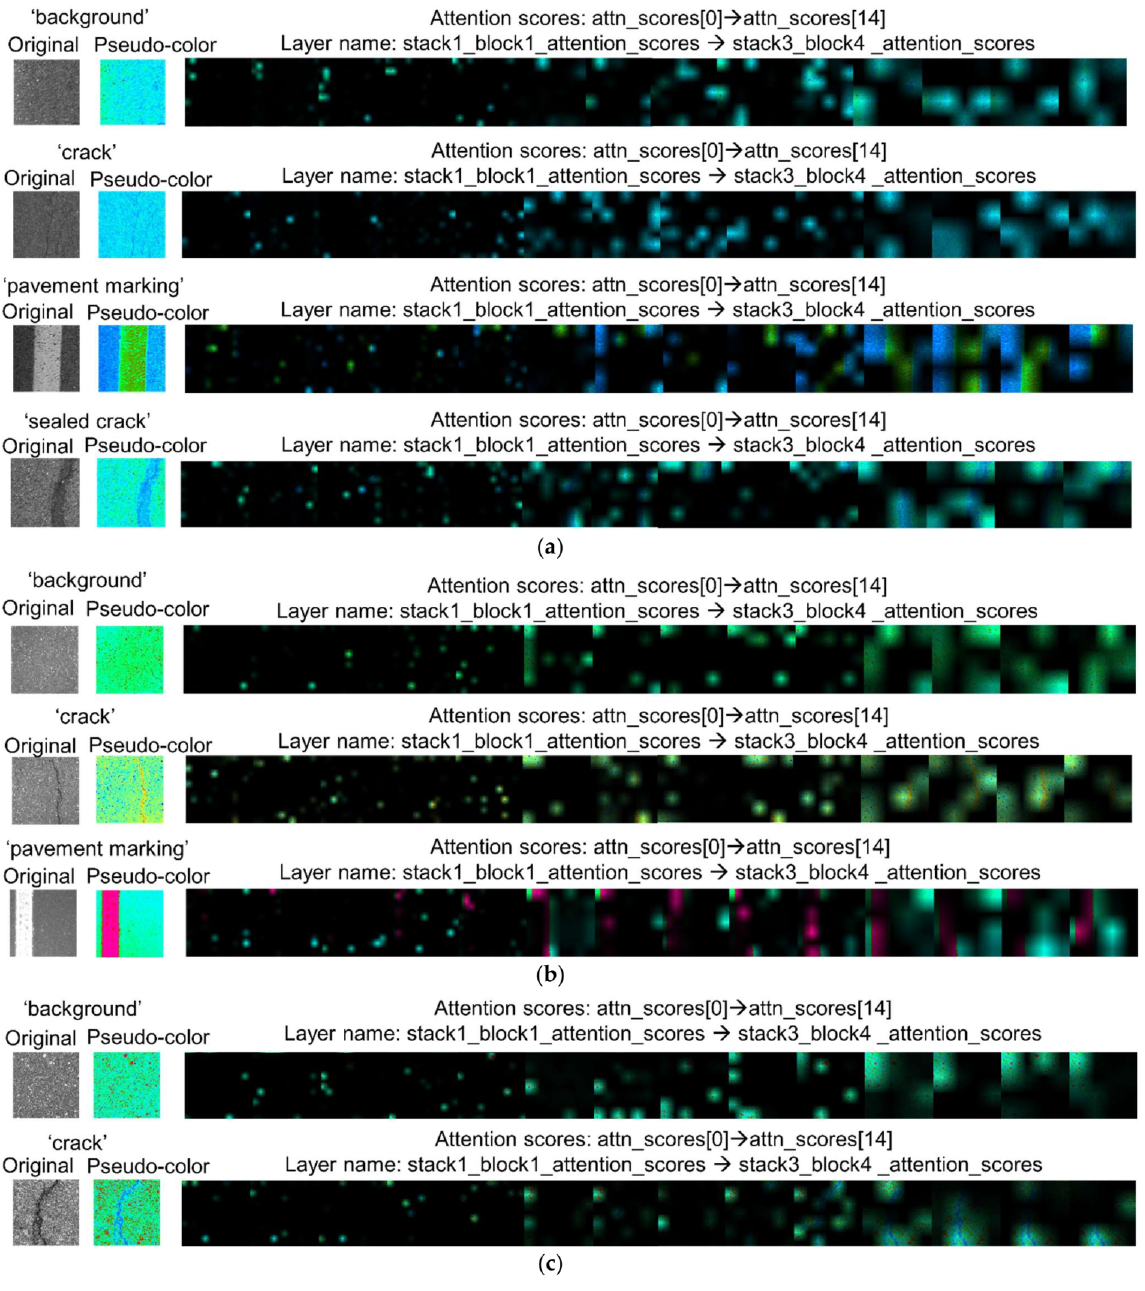
Figure 15. The attention score maps of different classifications. ( a ) JCAPs, ( b ) GAPs, ( c ) Crack500. Figure 15 shows the attention score map from the output of different attention blocks. The regions with higher attention scores were highlighted by applying masks to areas with lower attention scores. From the visual interpretation results of the attention layers, in the first few attention blocks, the network pays almost equal attention to all regions in the images. Subsequently, in the following few regions, the network begins to focus on some separated and scattered regions in the images. As the layers get deeper, the regions of the posterior attention layers are connected to a larger area. Overall, there is a trend that the areas with higher attention scores will cover more effective feature areas in the deeper